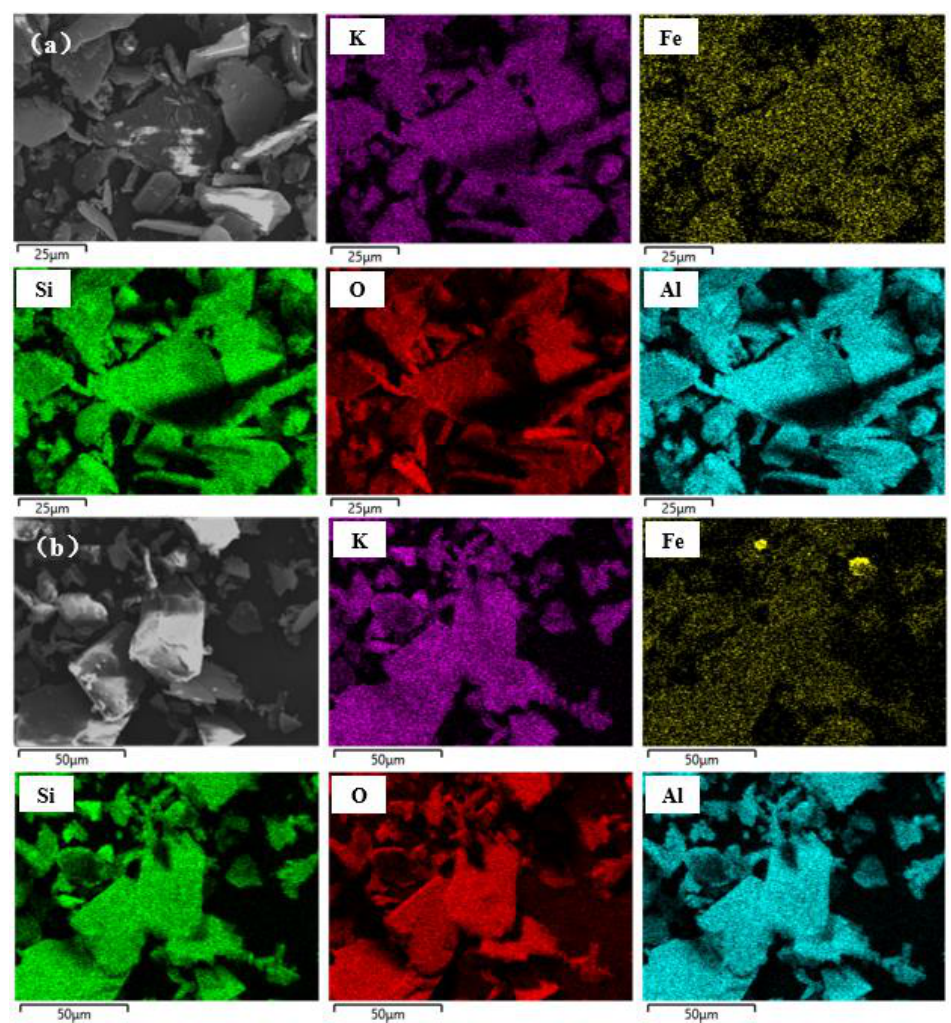
Figure 8. Element distribution on the sample surface at different temperatures (raw sericite ( a ), 1050 °C ( b )).